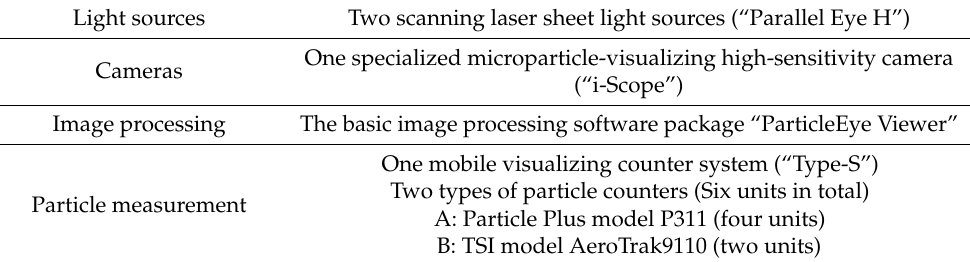
Table 1. Equipment